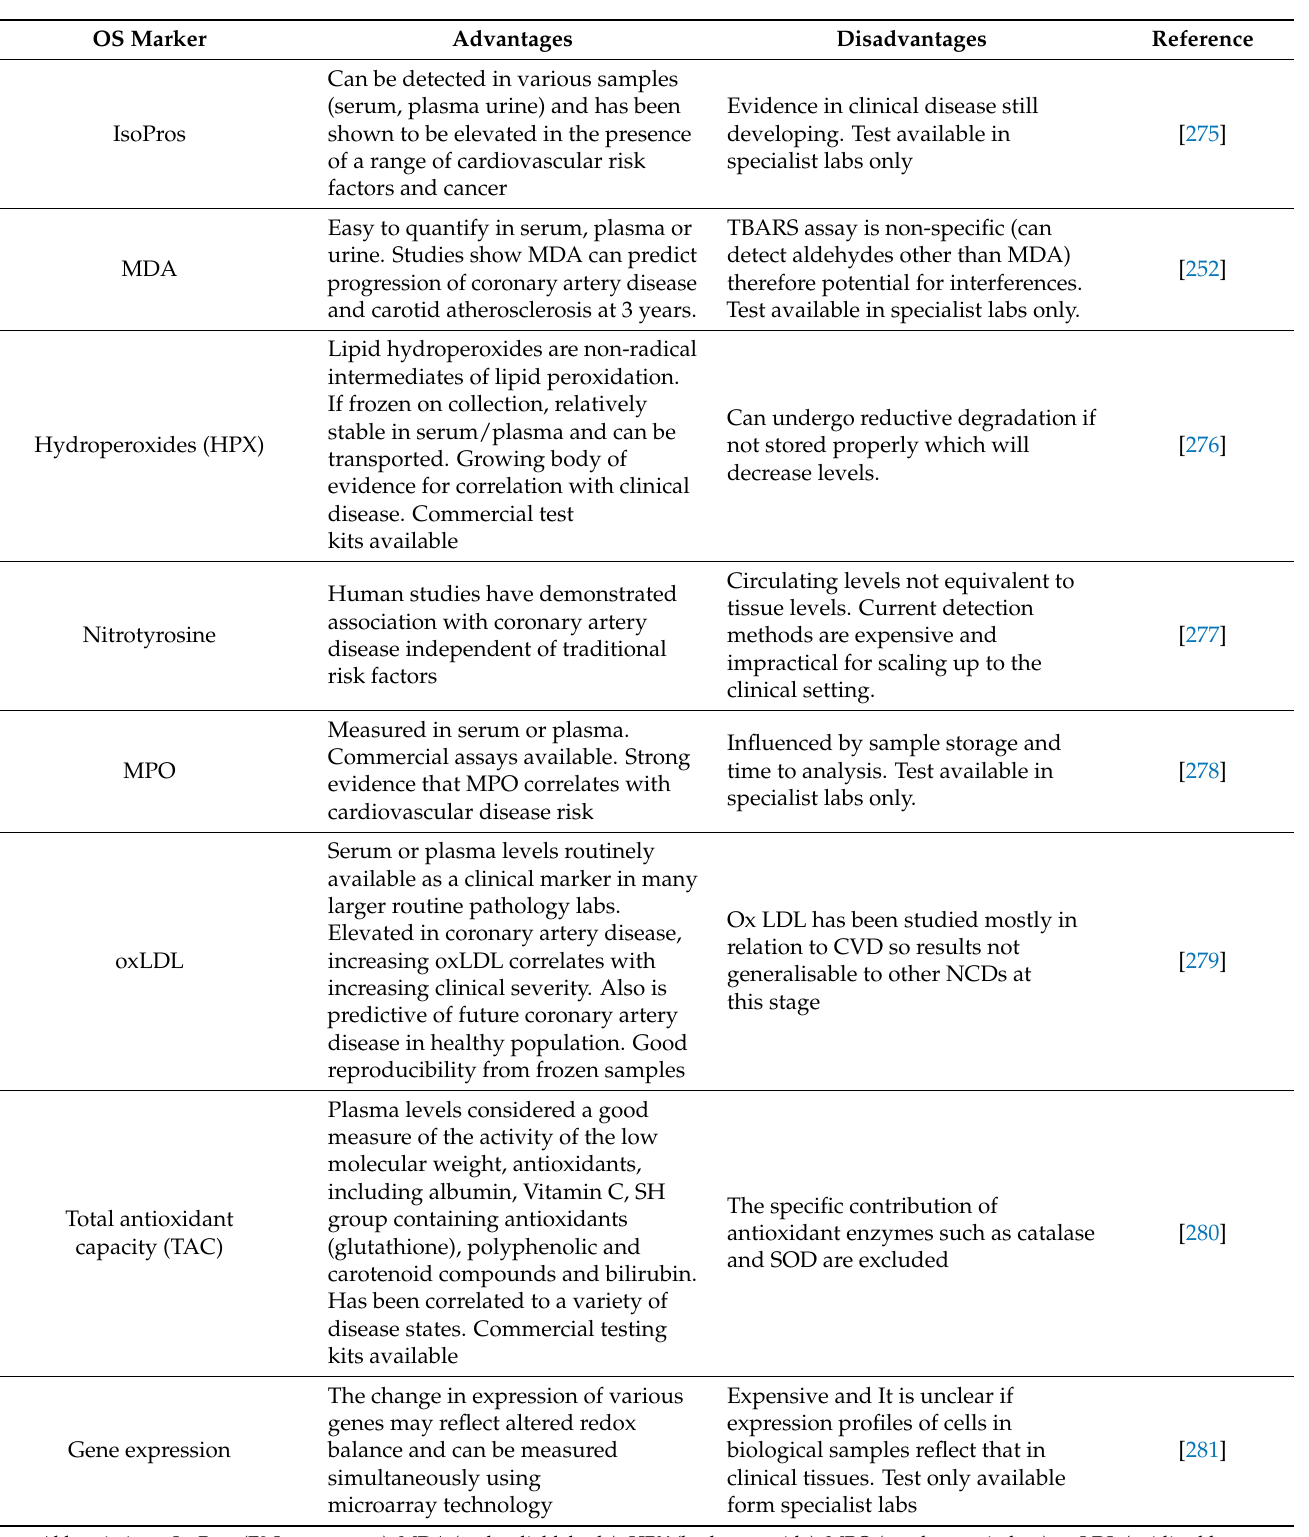
Table 1. Potential biomarkers of oxidative stress